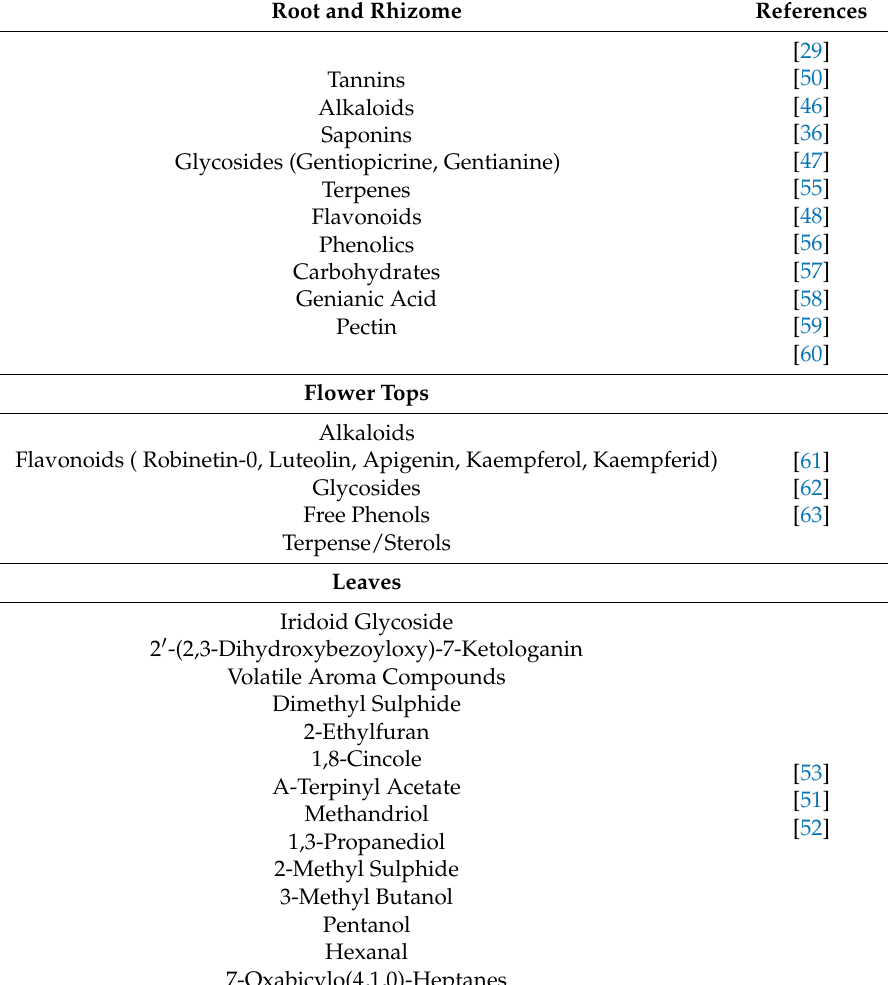
Table 1. Phytoconstituents of G. kurroo Royle.